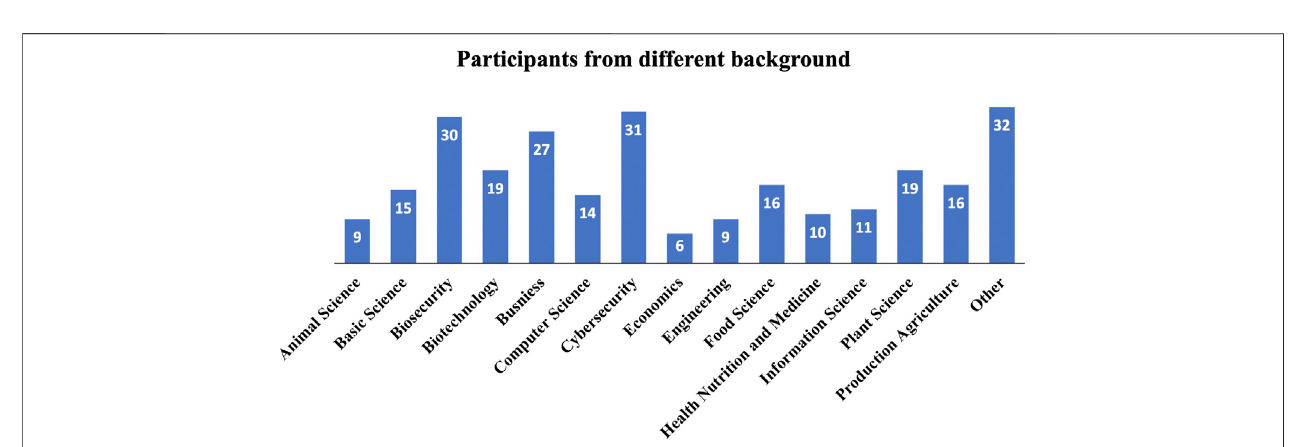
FIGURE 1 | Number of participants within disciplines participating in the Securing Agriculture and Food Economy (SAFE) with Cyberbiosecurity virtual workshop, October 6 – 7, 2020.